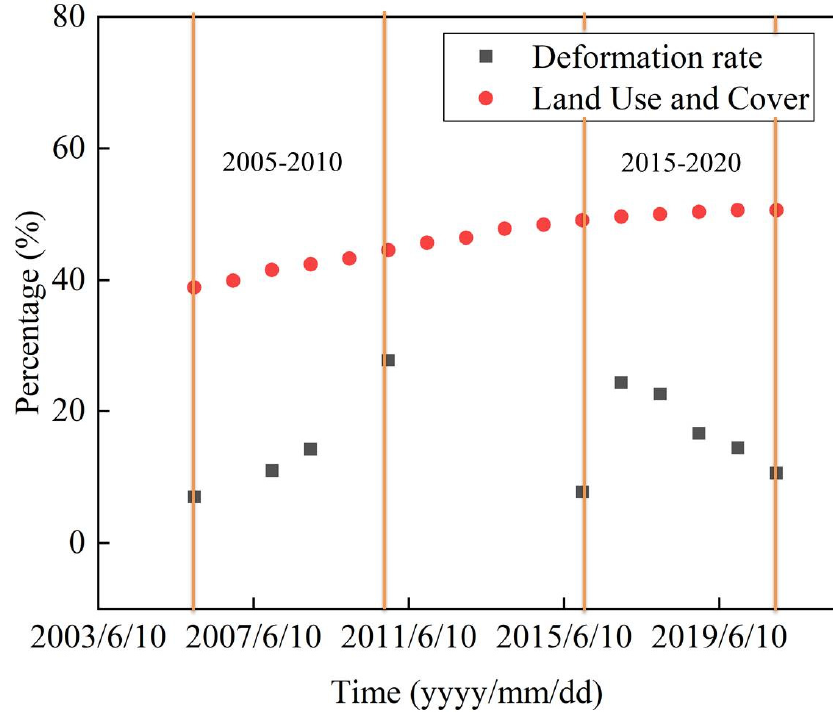
Figure 12. Change extent of construction land and deformation.